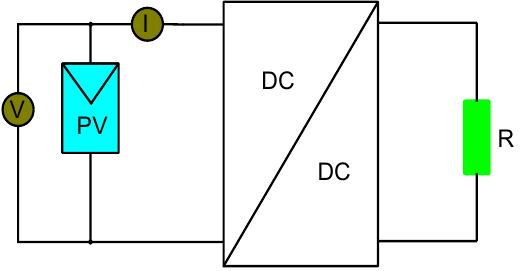
Figure 16. DC – DC converter tracer. Source [16] , own elaboration. Figure 16. DC–DC converter tracer. Source [16], own